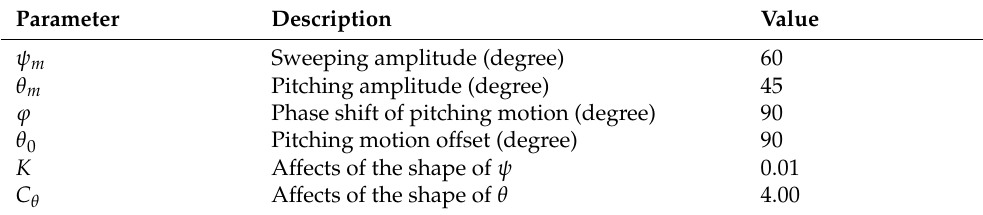
Table 4. Kinematic parameters used in sensitivity analysis for the geometric parameters.